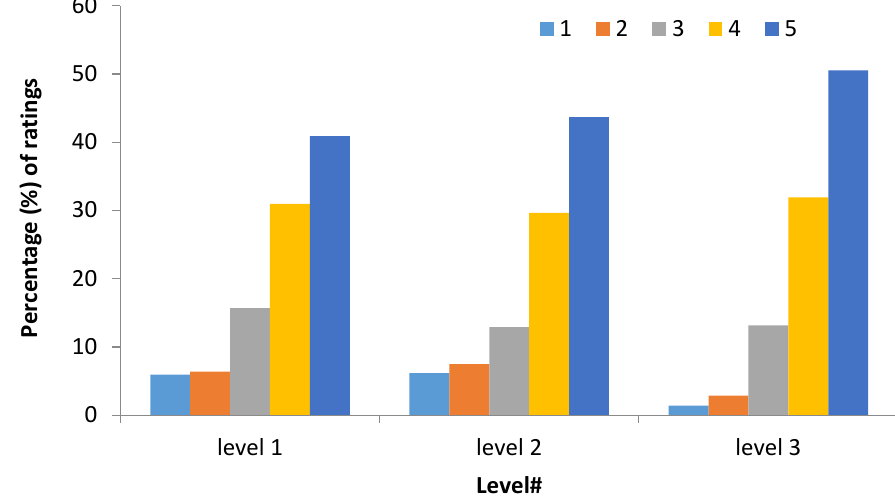
Figure 6. Summary of the ratings of the three levels of questions.